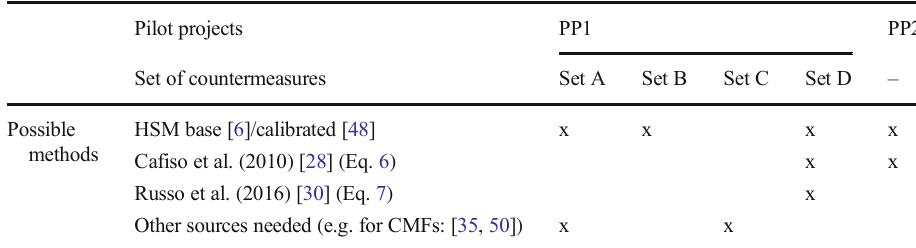
Table 5 Sources for models able to quantitatively estimate safety benefits of the different measures considered